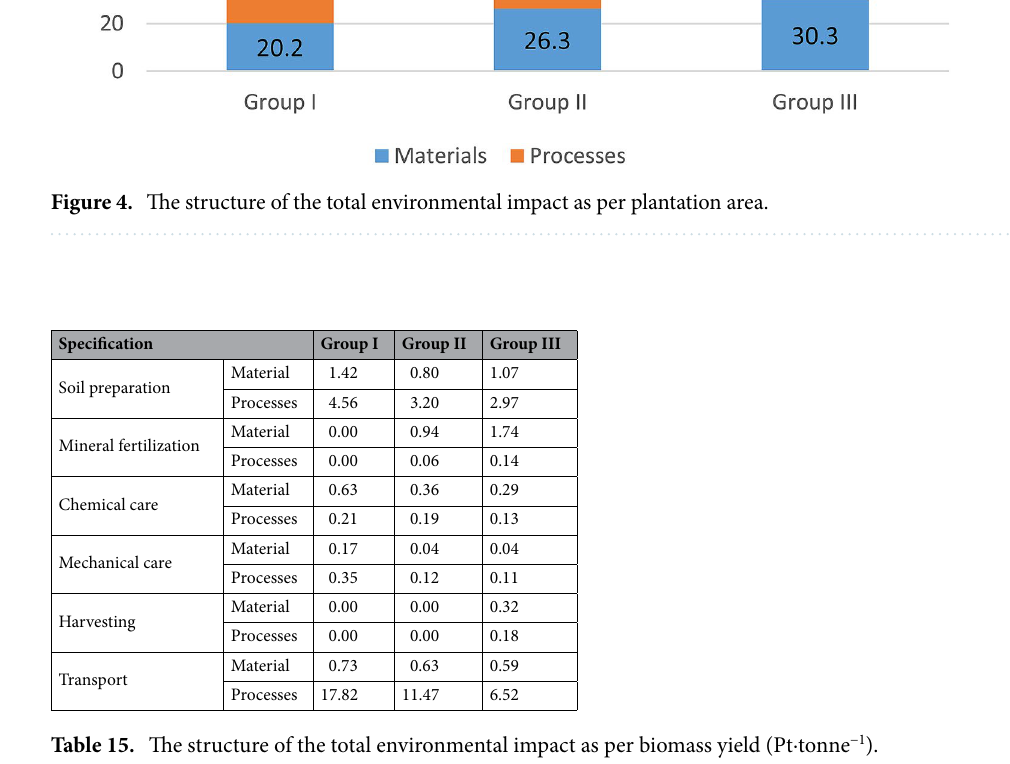
Table 15. The structure of the total environmental impact as per biomass yield (Pt·tonne −1